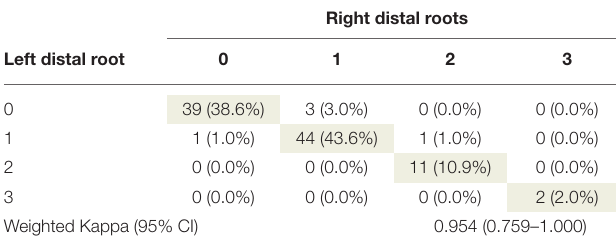
TABLE 4C | Apical position of root pairs within each tooth—right teeth. All mesial roots